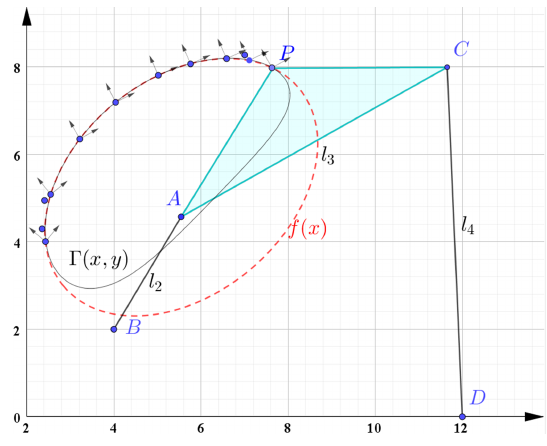
Figure 4. Tracing result of mixed